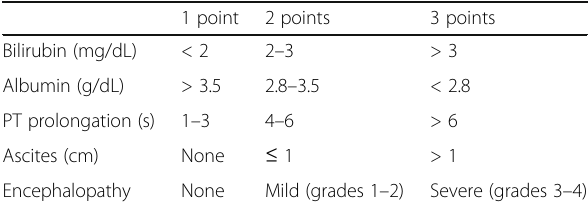
Table 1 Child-Pugh classification